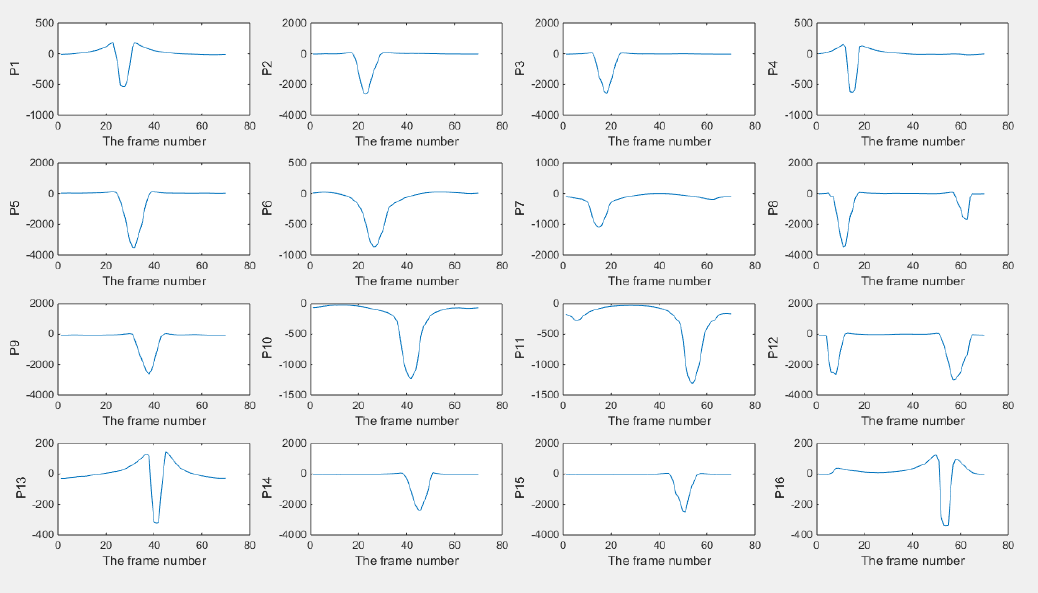
Figure 7. Plots of pixels of the result 2D experimental test with phantom inclusion in the ERT unit: plots of 16 pixels are displayed here, where the peak means that the inclusion entered and left the area of the specific pixel.